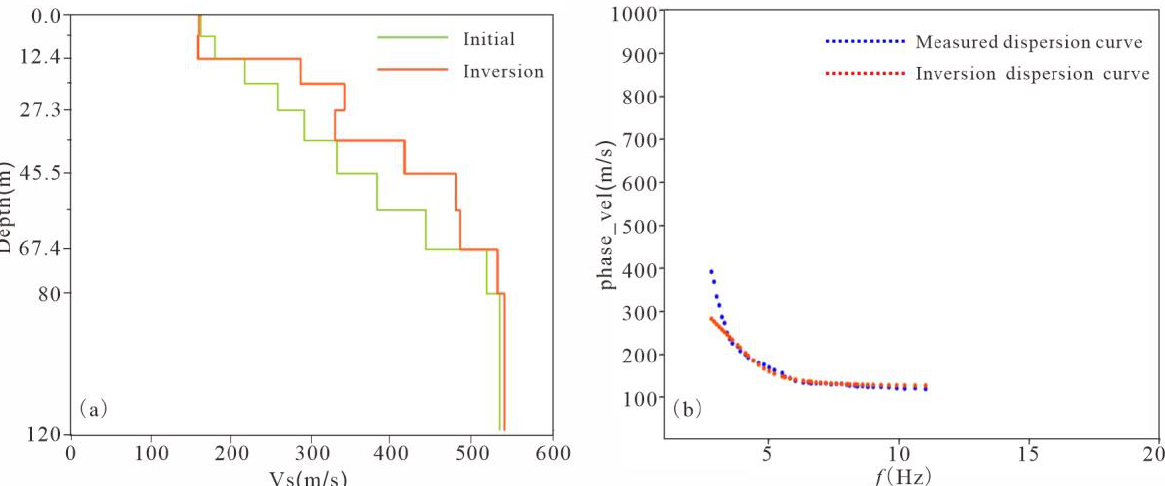
Figure 6. Inversion results of fundamental mode. ( a ) S-wave velocity structure of fundamental mode inversion. ( b ) Dispersion curve of measured noise data picked up in fundamental mode and the theoretical dispersion curve calculated after the initial model iteration.